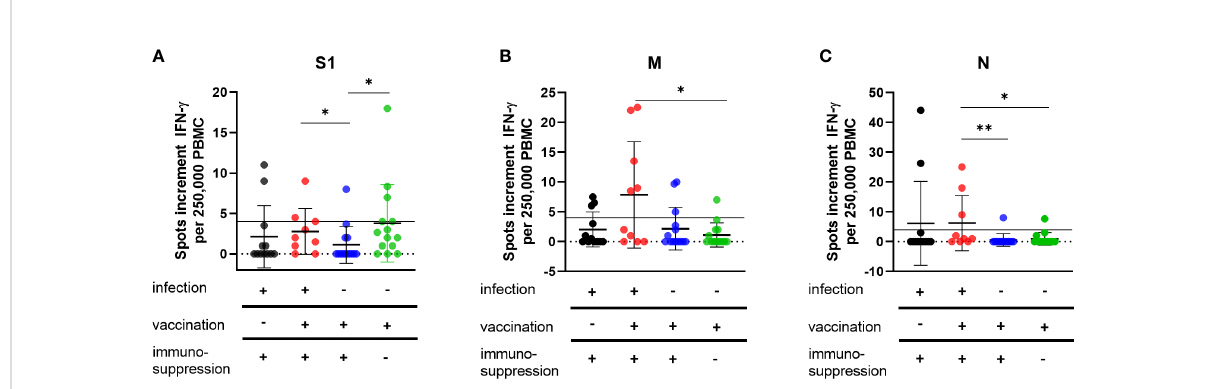
FIGURE 1 Cellular immunity to SARS-CoV-2 antigens in vaccinated and/or recovered immunosuppressed individuals. Cellular immune responses towards SARS-CoV-2 S1 (A) , M (B) and N (C) antigens were determined by IFN- g ELISpot assay. Please note that the scales differ. Horizontal lines indicate mean values, error bars indicate the standard deviation (SD). The dotted gray line represents the assay cut-off. Differences between the groups were compared by Mann-Whitney U test (*p <